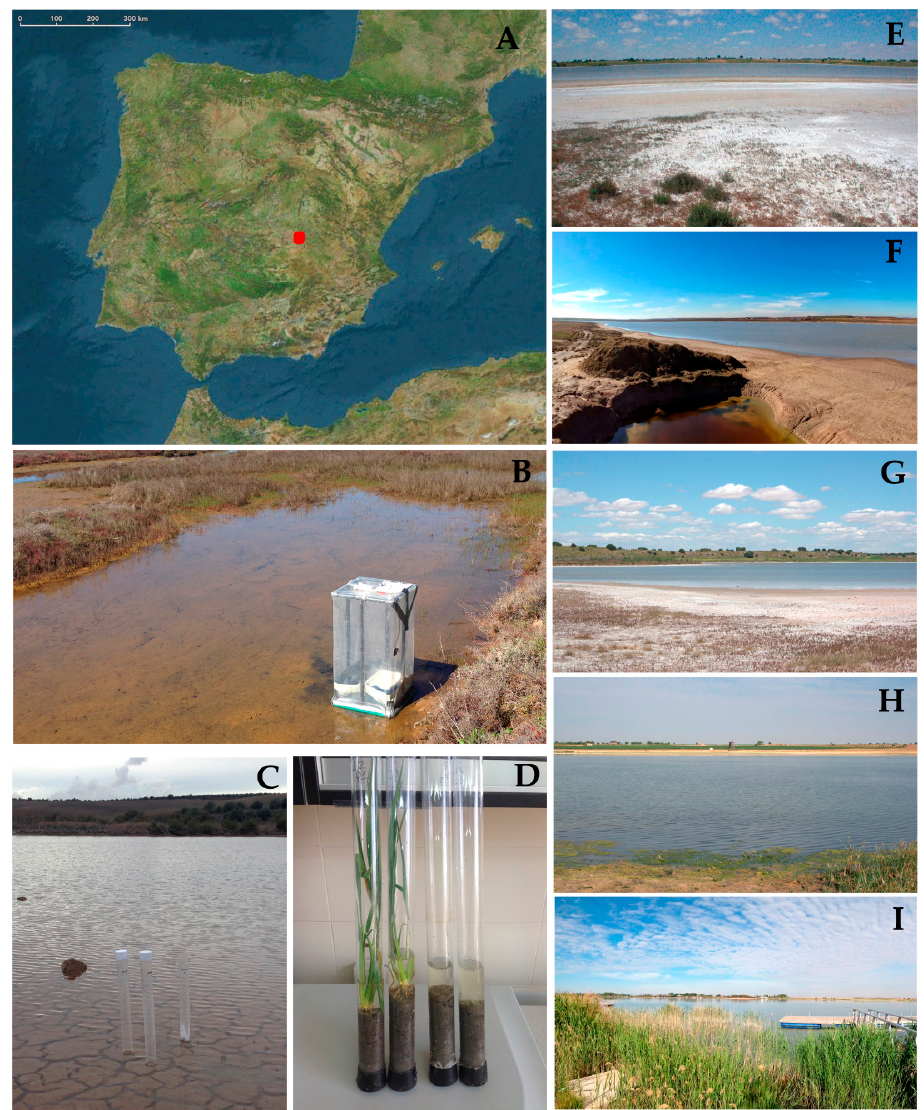
Figure 1. ( A ) Location of the study area in the Iberian Peninsula; ( B ) incubation of a static flow chamber in one of the studied lakes; ( C ) incubation of sediment cores in one of the studied lakes; ( D ) detail of sediment cores setting for the measurement of methane release rates; ( E ) Lake Alcahozo; ( F ) Lake Tirez; ( G ) Lake Salicor; ( H ) Lake Manjavacas; and ( I ) Lake Grande de Villafranca.